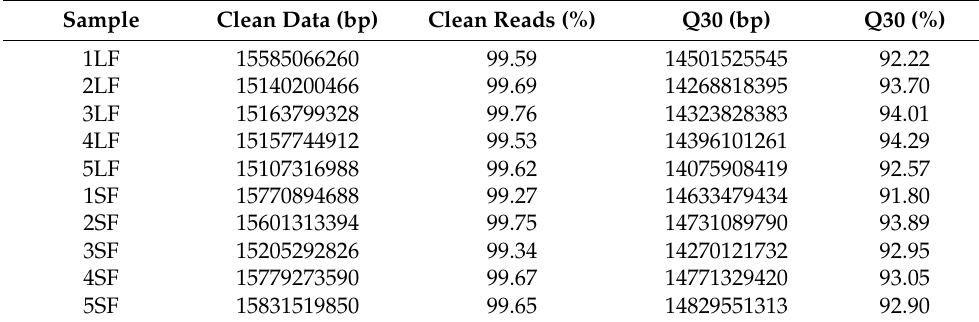
Table 1. Quality control of RNA-seq